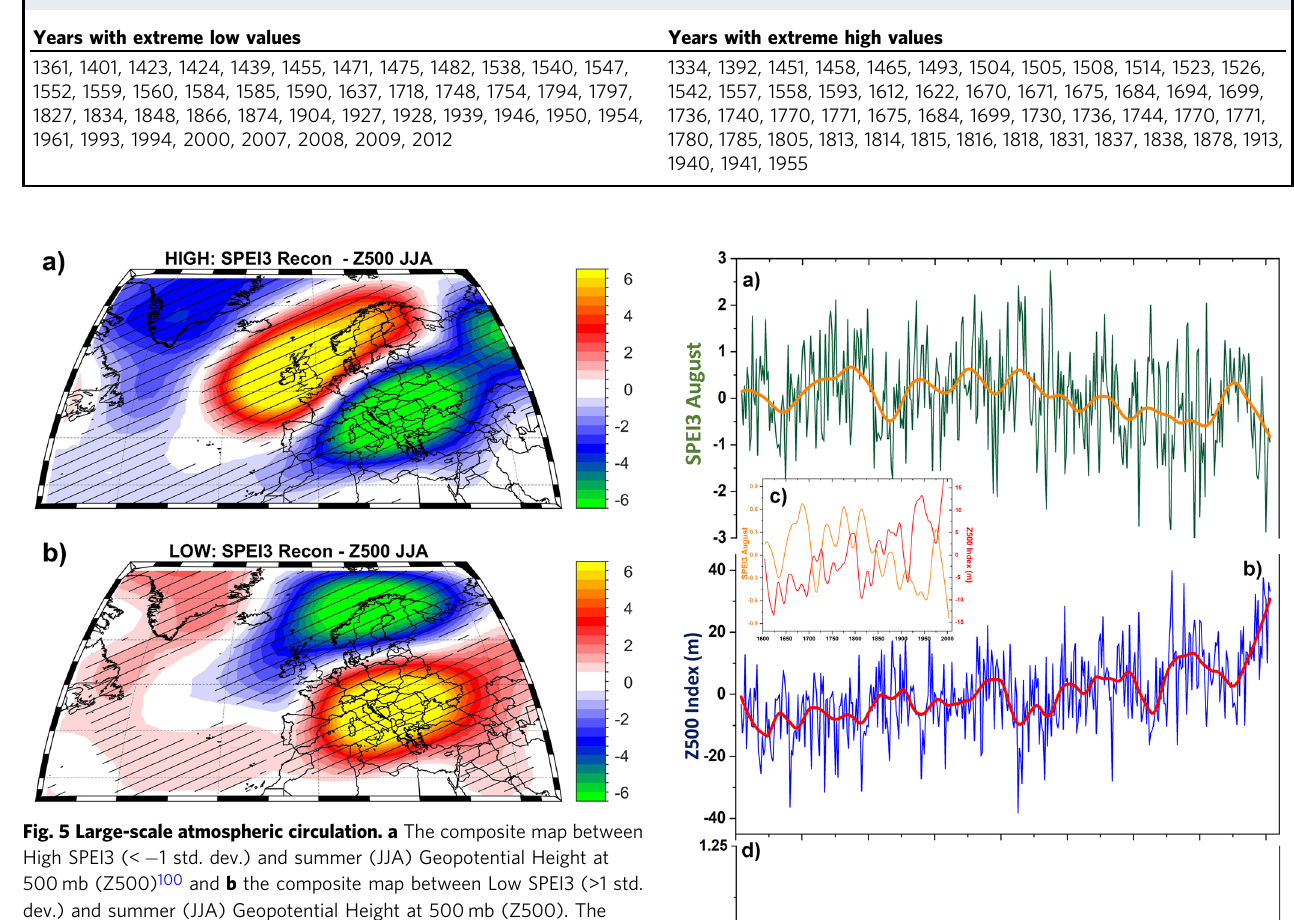
Table 2 The years corresponding to the low values (August SPEI3 < − 1.5) and high values (August SPEI3 > 1.5) over the 1331 – 2012CE period.